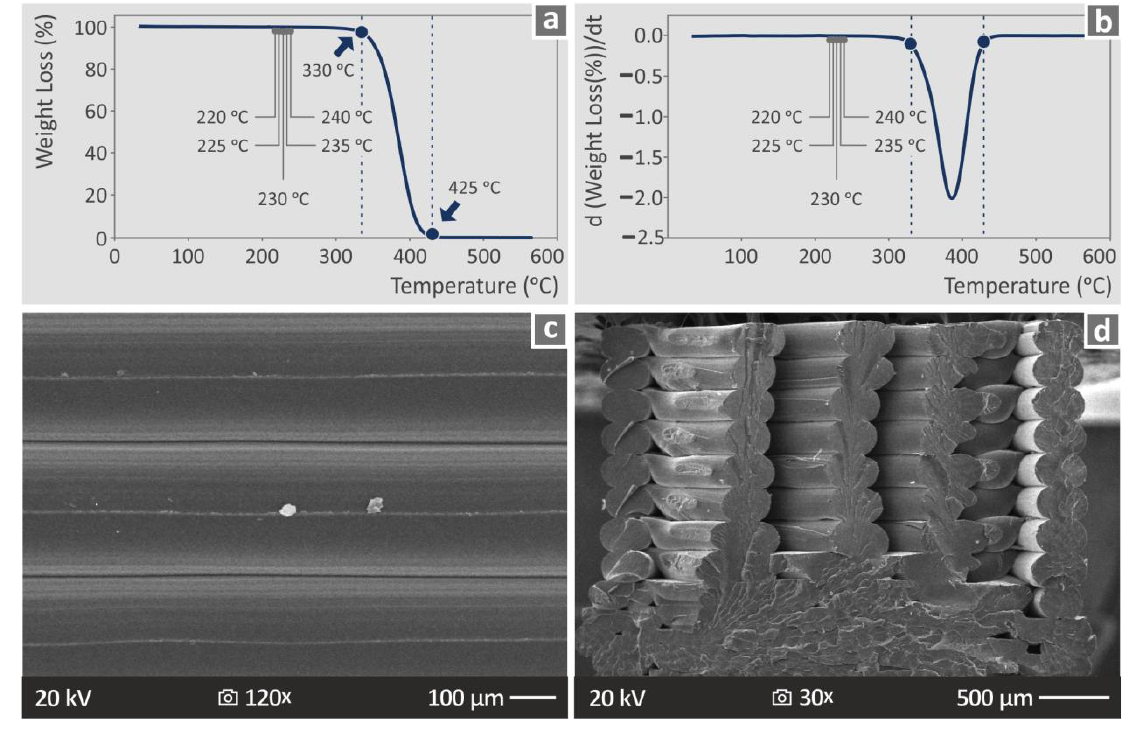
Figure 5. ( a ) TGA weight loss (%) vs. temperature (°C) graph produced during the study of the thermal properties of the PMMA polymer used, ( b ) corresponding d(weight loss)/dt graph produced with DSC, and SEM images from ( c ) the side surface, and ( d ) the fracture surface produced after the completion of the tensile test of a PMMA MEX 3D-printed sample. Table 1. Taguchi L25 Design: control parameters and